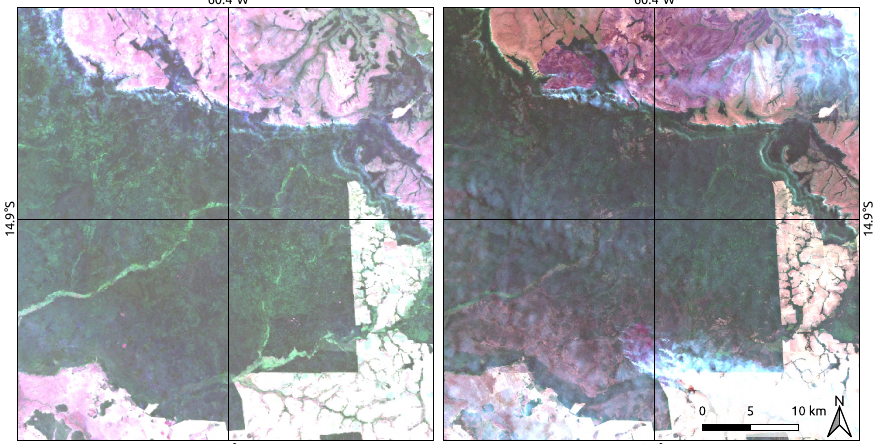
Figure 4. Reference image ( left ) and the later instant ( right —9 October 2020) for Area 2. Representa- tions in natural color